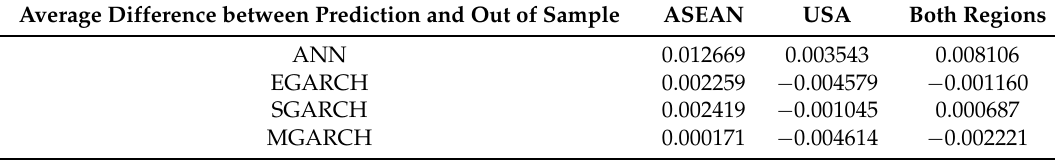
Table 2. Comparison of average results between five-step ahead prediction and actual out of sample values. Average Difference between Prediction and Out of Sample